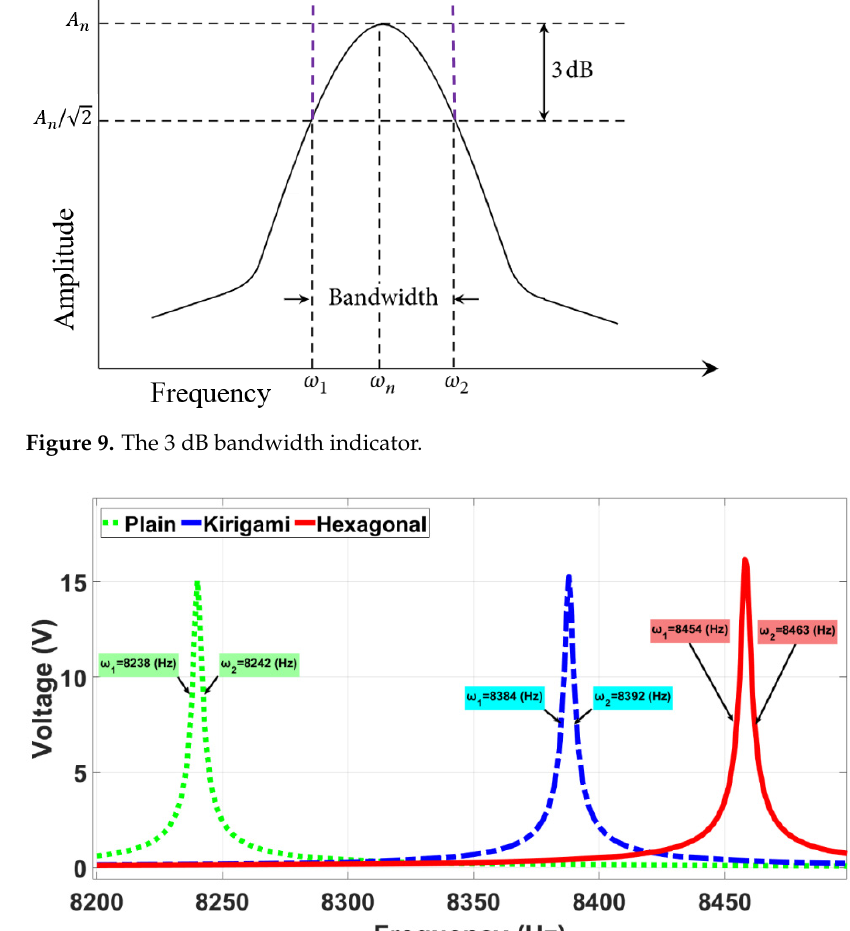
Figure 10. The lower and upper cut-off frequencies of the 3 dB BW for all sensors. All points use the same excitation of 5 Pa. Table 4. 3 dB bandwidth of the proposed sensors.